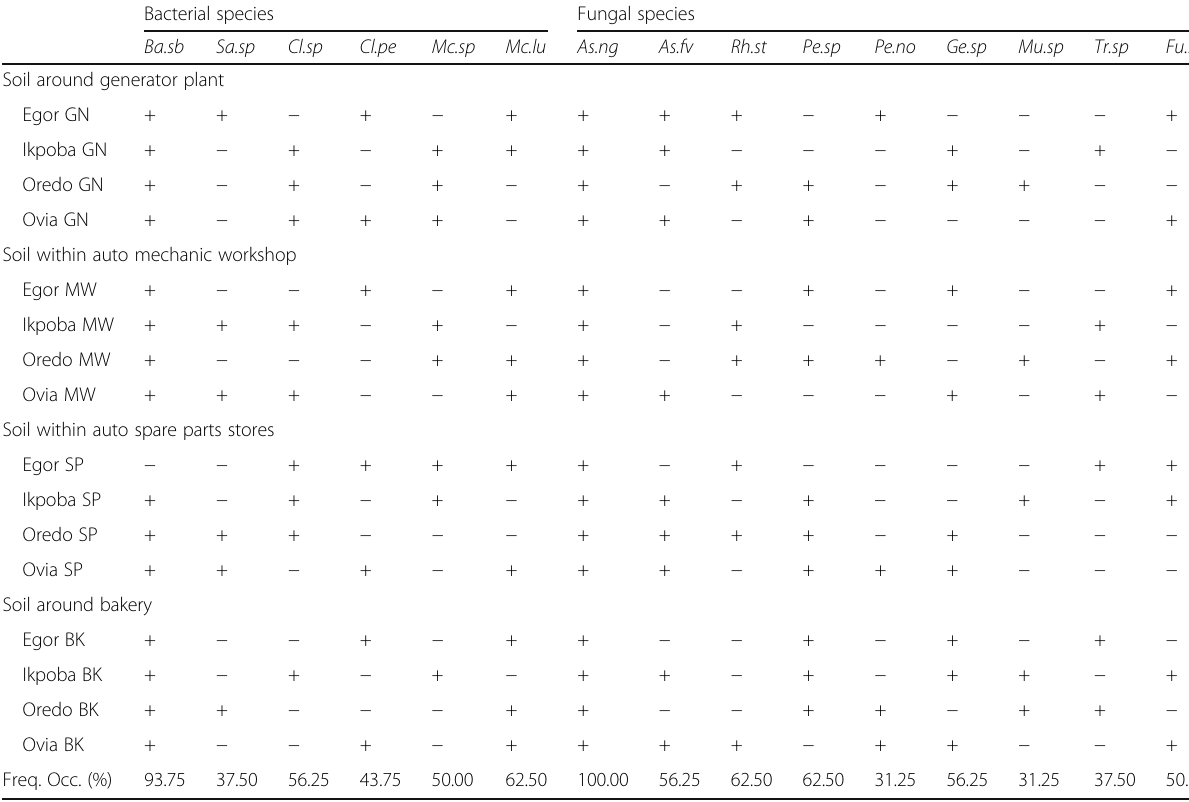
Table 6 Microbial species composition of waste oil-polluted soil collected from designated sites within Benin metropolis to